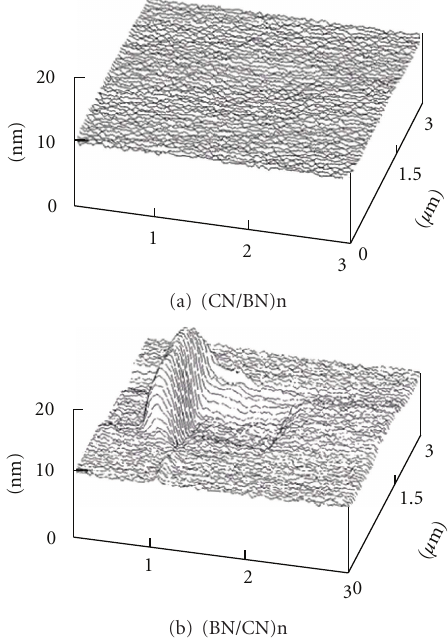
Figure 10: Nanowear of (a) (CN/BN)n and (b) (BN/CN)n films with a layer period of 4nm, obtained by applying a load of 50 µ N and one number of scanning